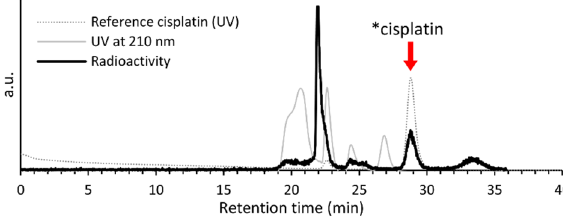
Figure 3. Radiochromatogram obtained during preparative HPLC.